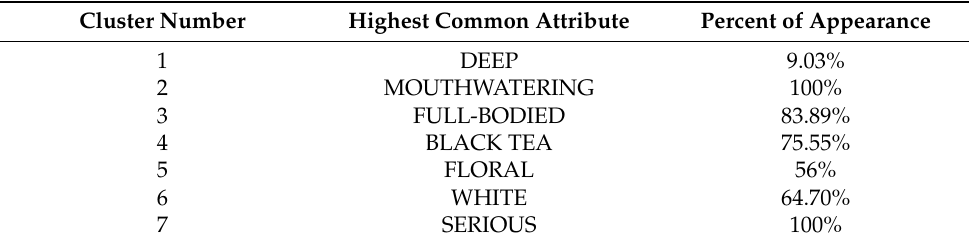
Table 4. Highest common attributes. The percentages shown reflect the idea that cluster 1 may not be considered as a collection of similar wines, but all other clusters present acceptable percentages when considering the number of existing attributes.